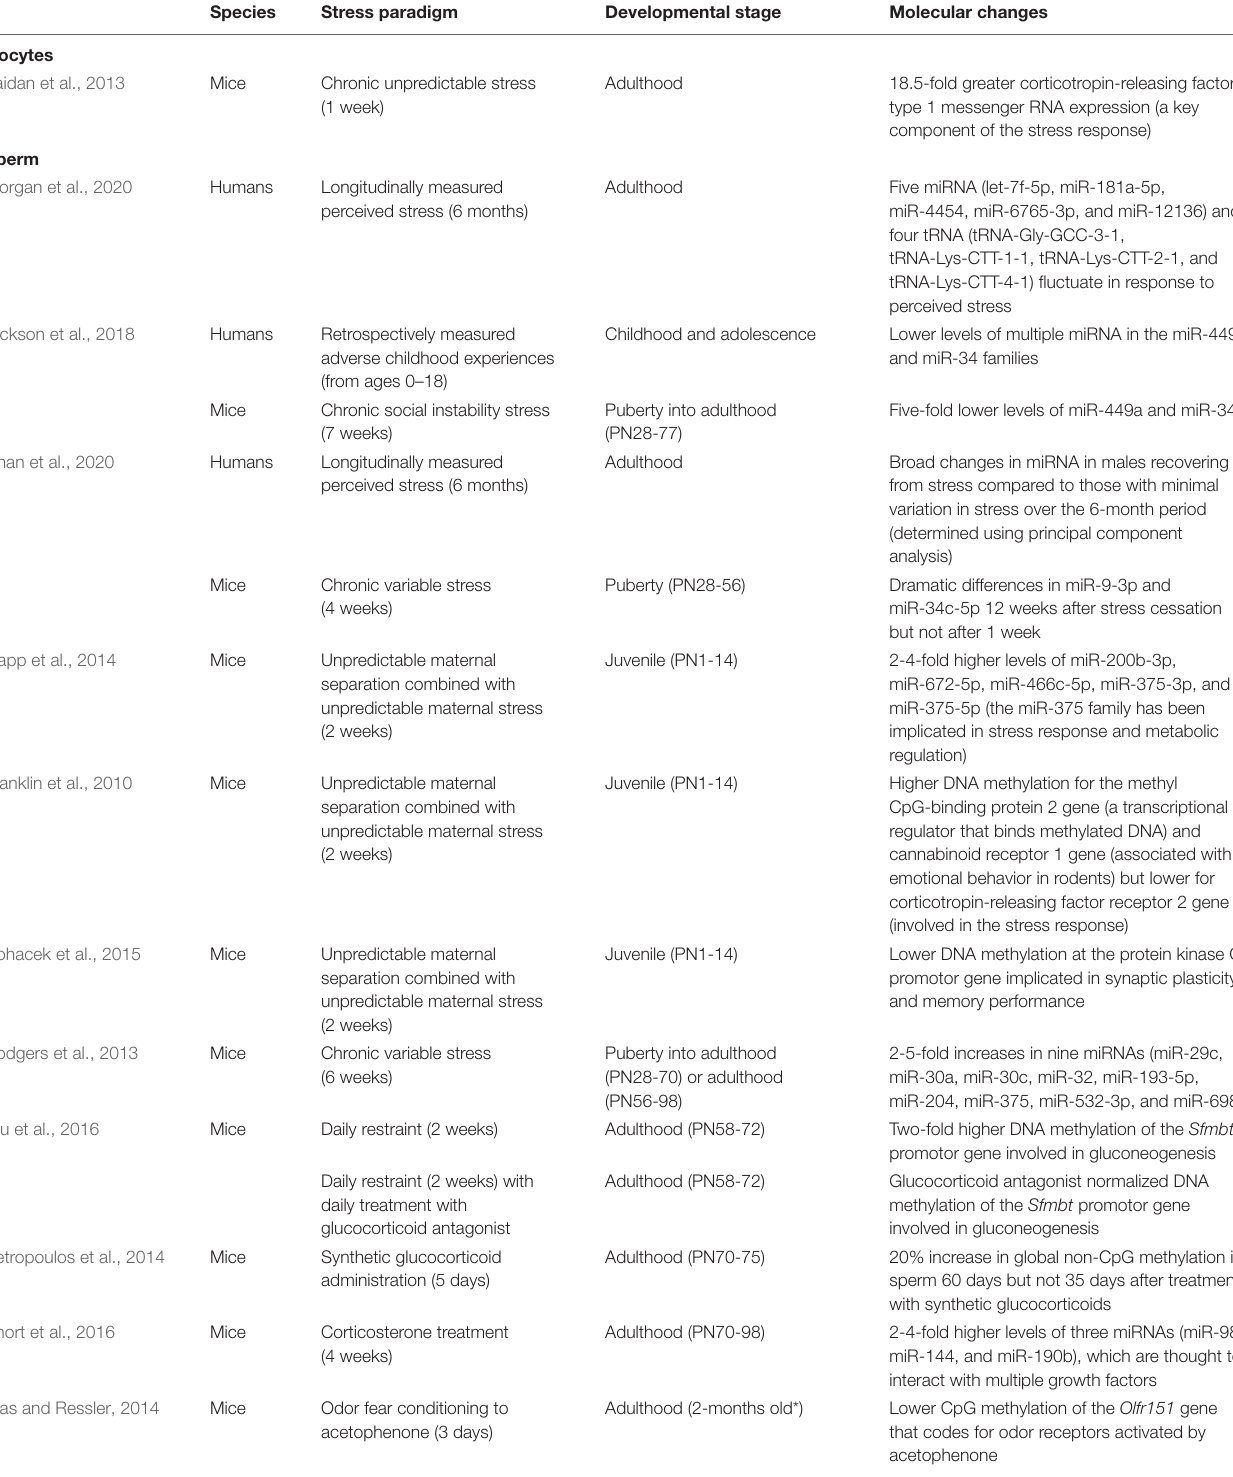
TABLE 1 | Summary of studies testing for stress-induced or stress hormone-induced molecular changes in germ